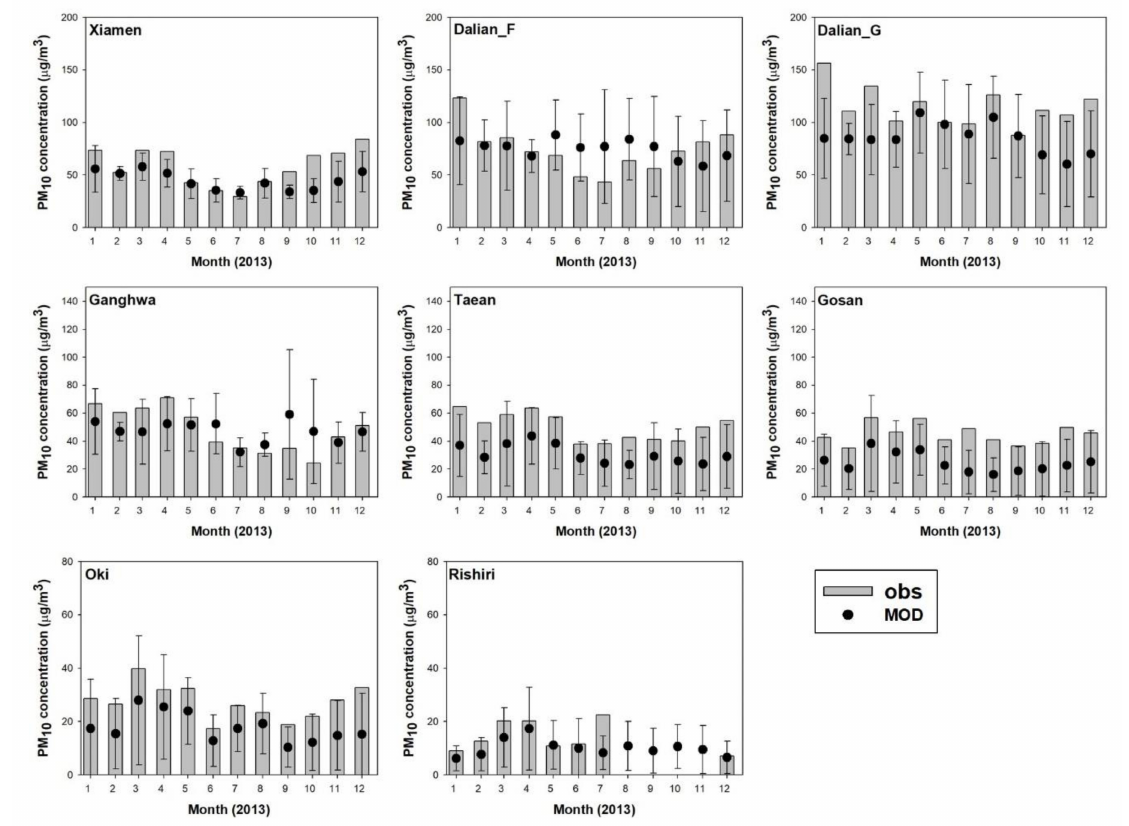
Figure 7. Observed and simulated monthly average PM 10 concentrations at exit-and-entrance sites in China, Japan, and Korea. The site locations and characteristics are indicated in Figure 1 and Supplementary Table